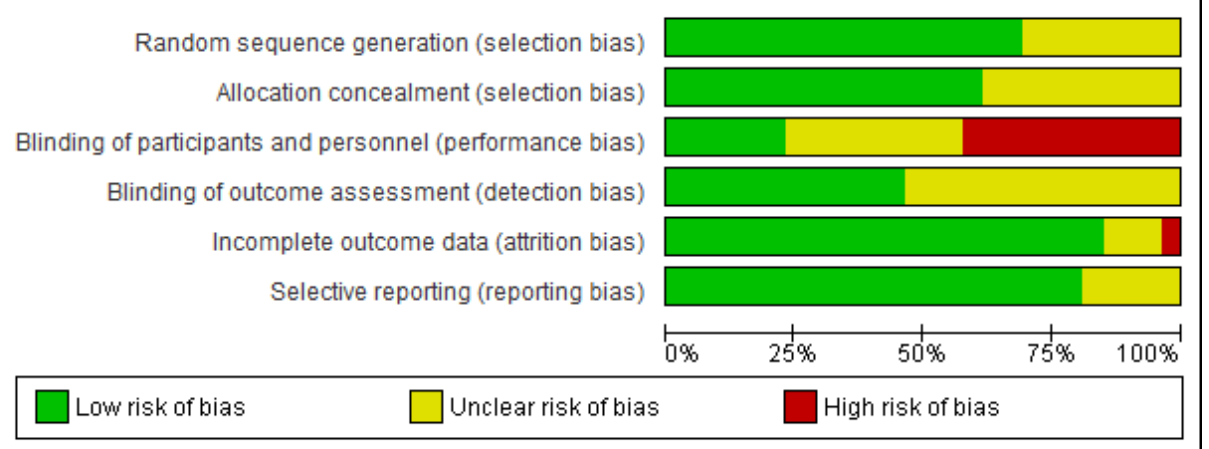
Figure 2. Risk of bias assessment. Authors' judgments about each methodological quality item are presented as percentages across all included